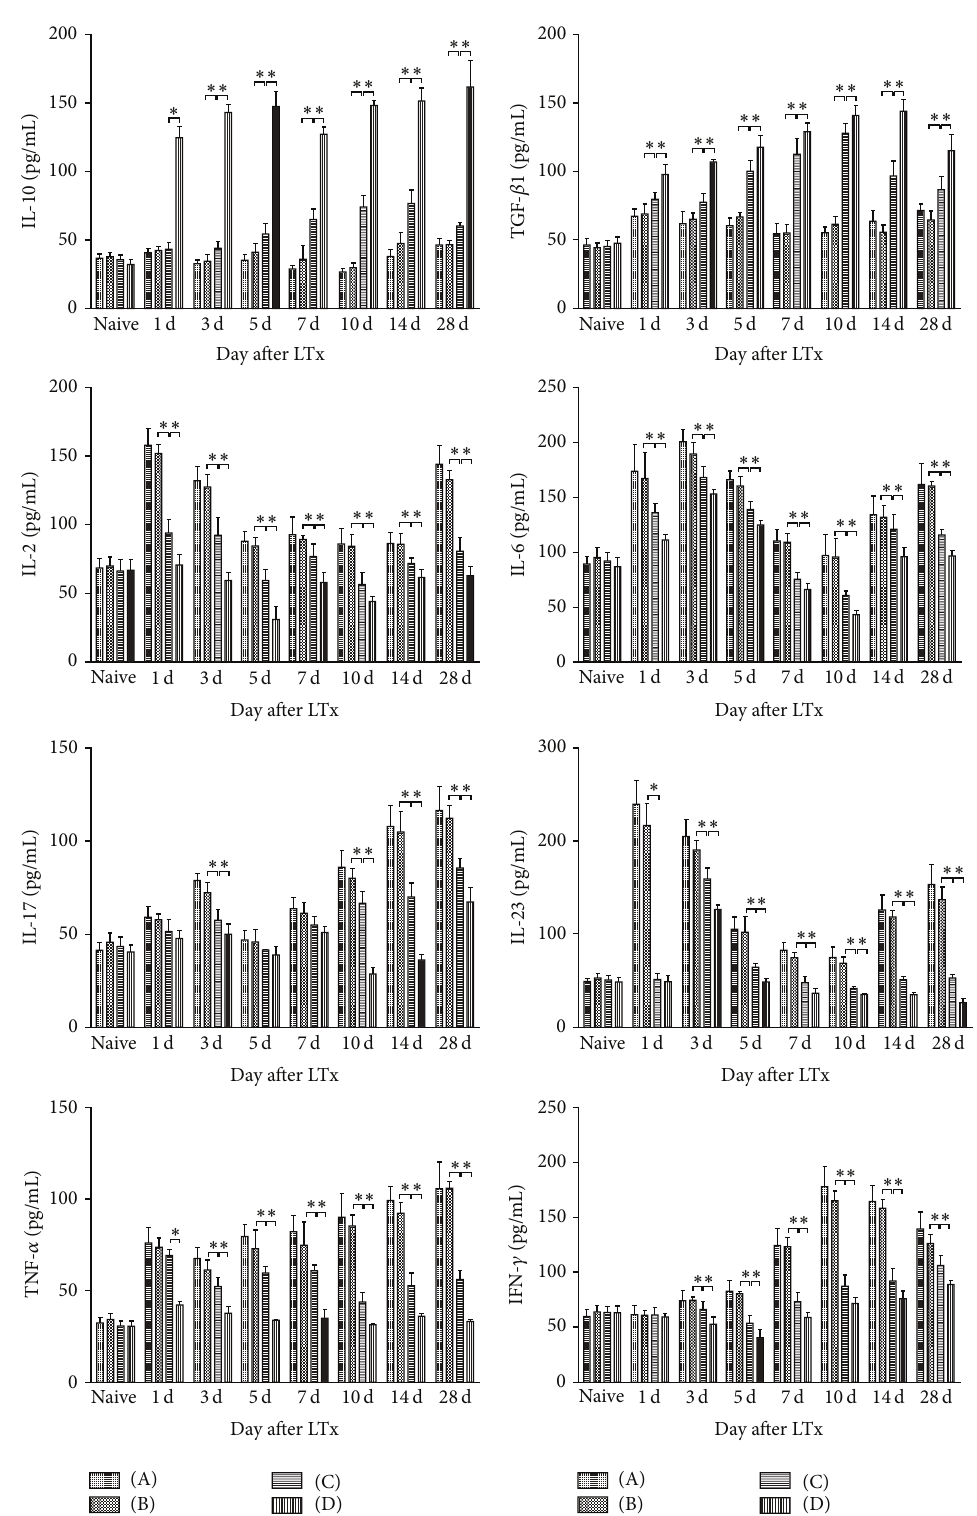
Figure 5: IL-10, TGF- 𝛽 , IL-2, IL-6, IL-17, IL-23, TNF- 𝛼 , and IFN- 𝛾 concentrations in recipient serum. (A) Normal saline group; (B) HO-1 group; (C) BMMSCs group; (D) HO-1/MSCs group. Cytokine concentrations in the recipient serum were measured by ELISA on days 1, 3, 5, 7, 10, 14, and 28 after transplantation ( 𝑛 = 5 in each group). Data are expressed as the mean ± SD ( ∗ 𝑃 < 0.05 ). Levels of IL-10 and TGF- 𝛽 were significantly higher, while levels of IL-2, IL-6, IL-17, IL-23, TNF- 𝛼 , and IFN- 𝛾 were significantly lower in the HO-1/MSCs group than those of control